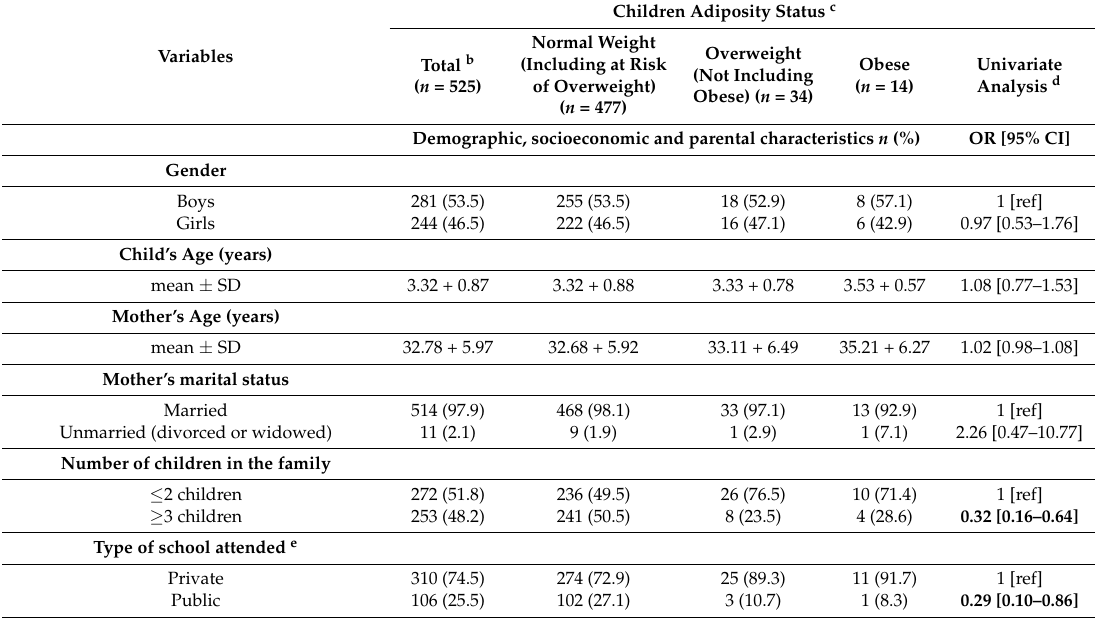
Table 2. Association of demographic, socioeconomic, eating habits and dietary intakes with preschoolers’ weight status, Lebanon ( n = 525) a